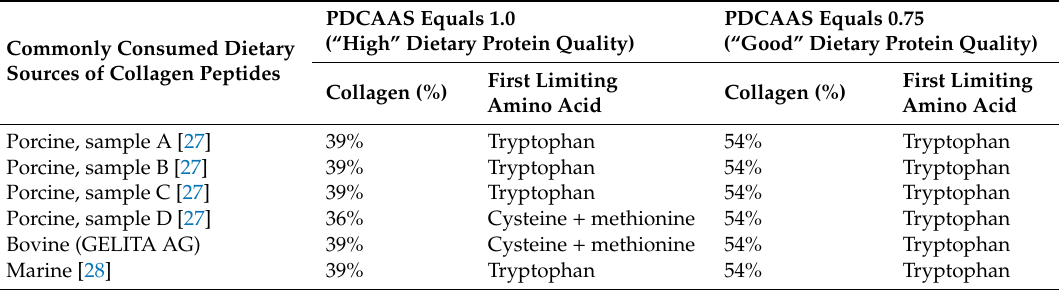
Table 1. Outcomes from the iterative PDCAAS calculations devised to identify the highest percentage of each type of collagen peptides that may be incorporated in the standard American diet, while maintaining dietary protein quality.